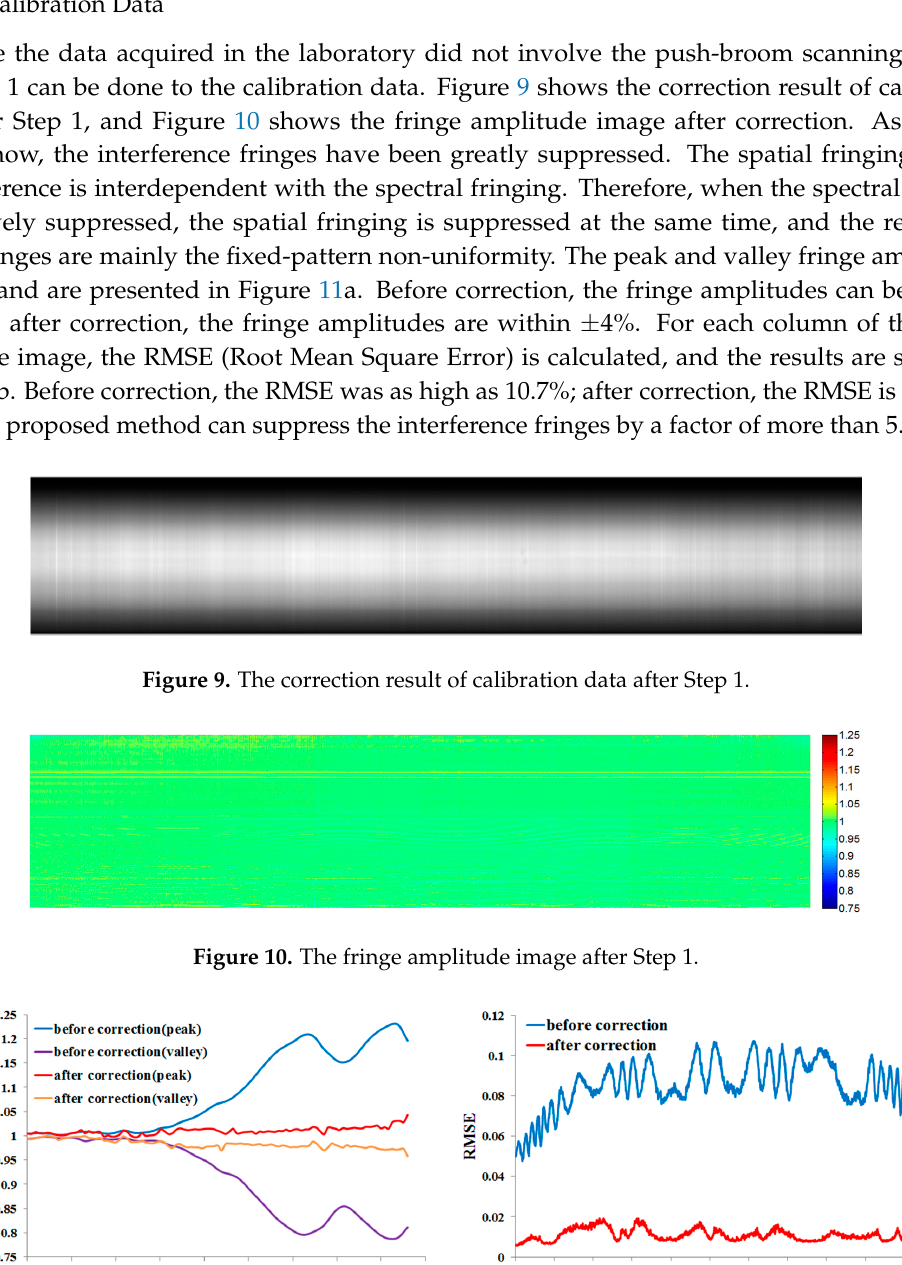
Figure 8. ( a ) Spectral response curves of four typical targets acquired by Camera 1; ( b ) Spectral response curves of two typical targets acquired by Camera 2.